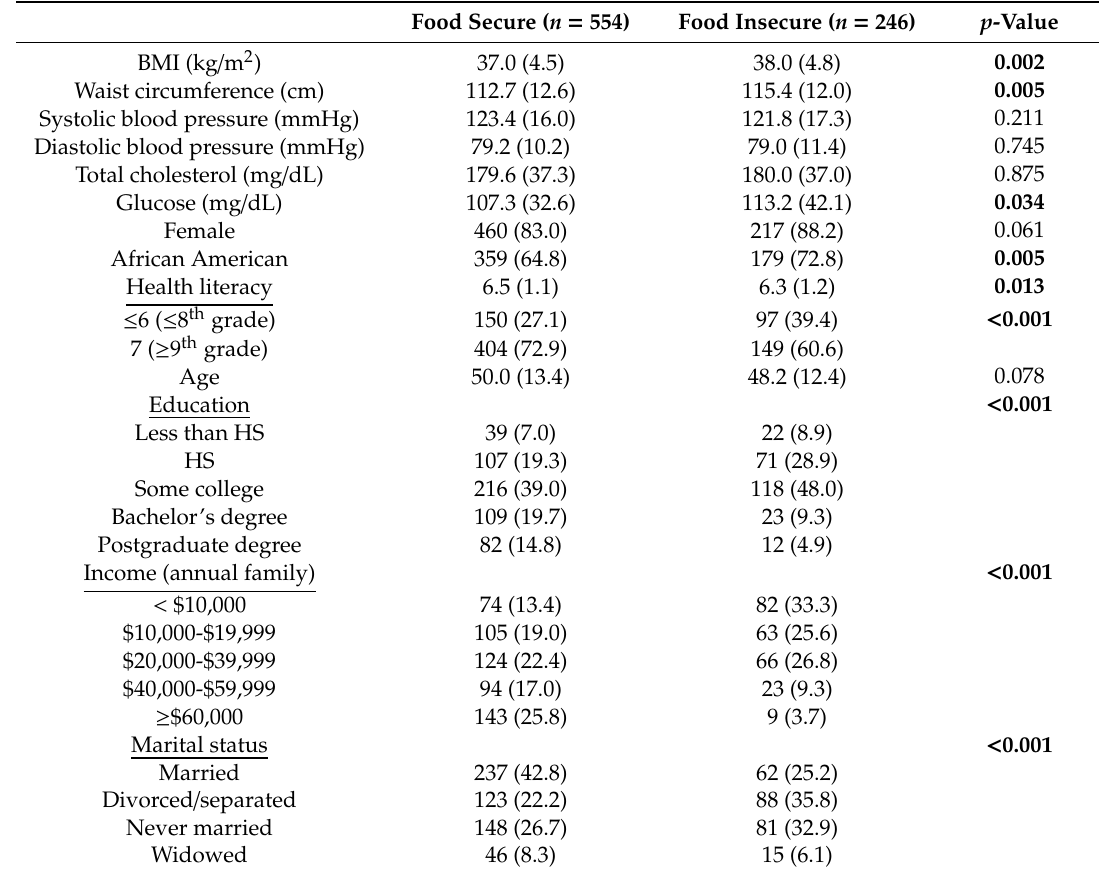
Table 2. Baseline Characteristics of Promoting Successful Weight Loss in Primary Care in Louisiana (PROPEL) Patients by Food Security